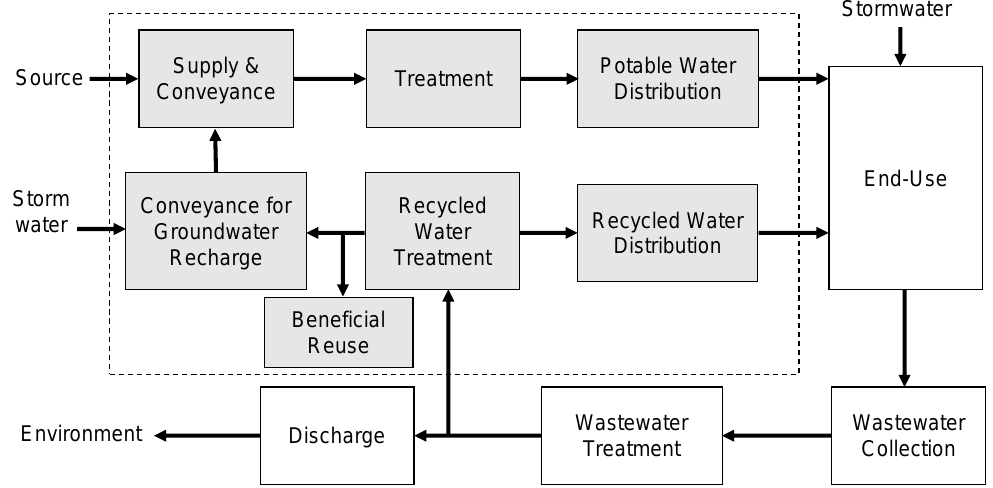
Figure 2. Block diagram of the general components of a water supply system. The dashed box indicates the boundaries of this